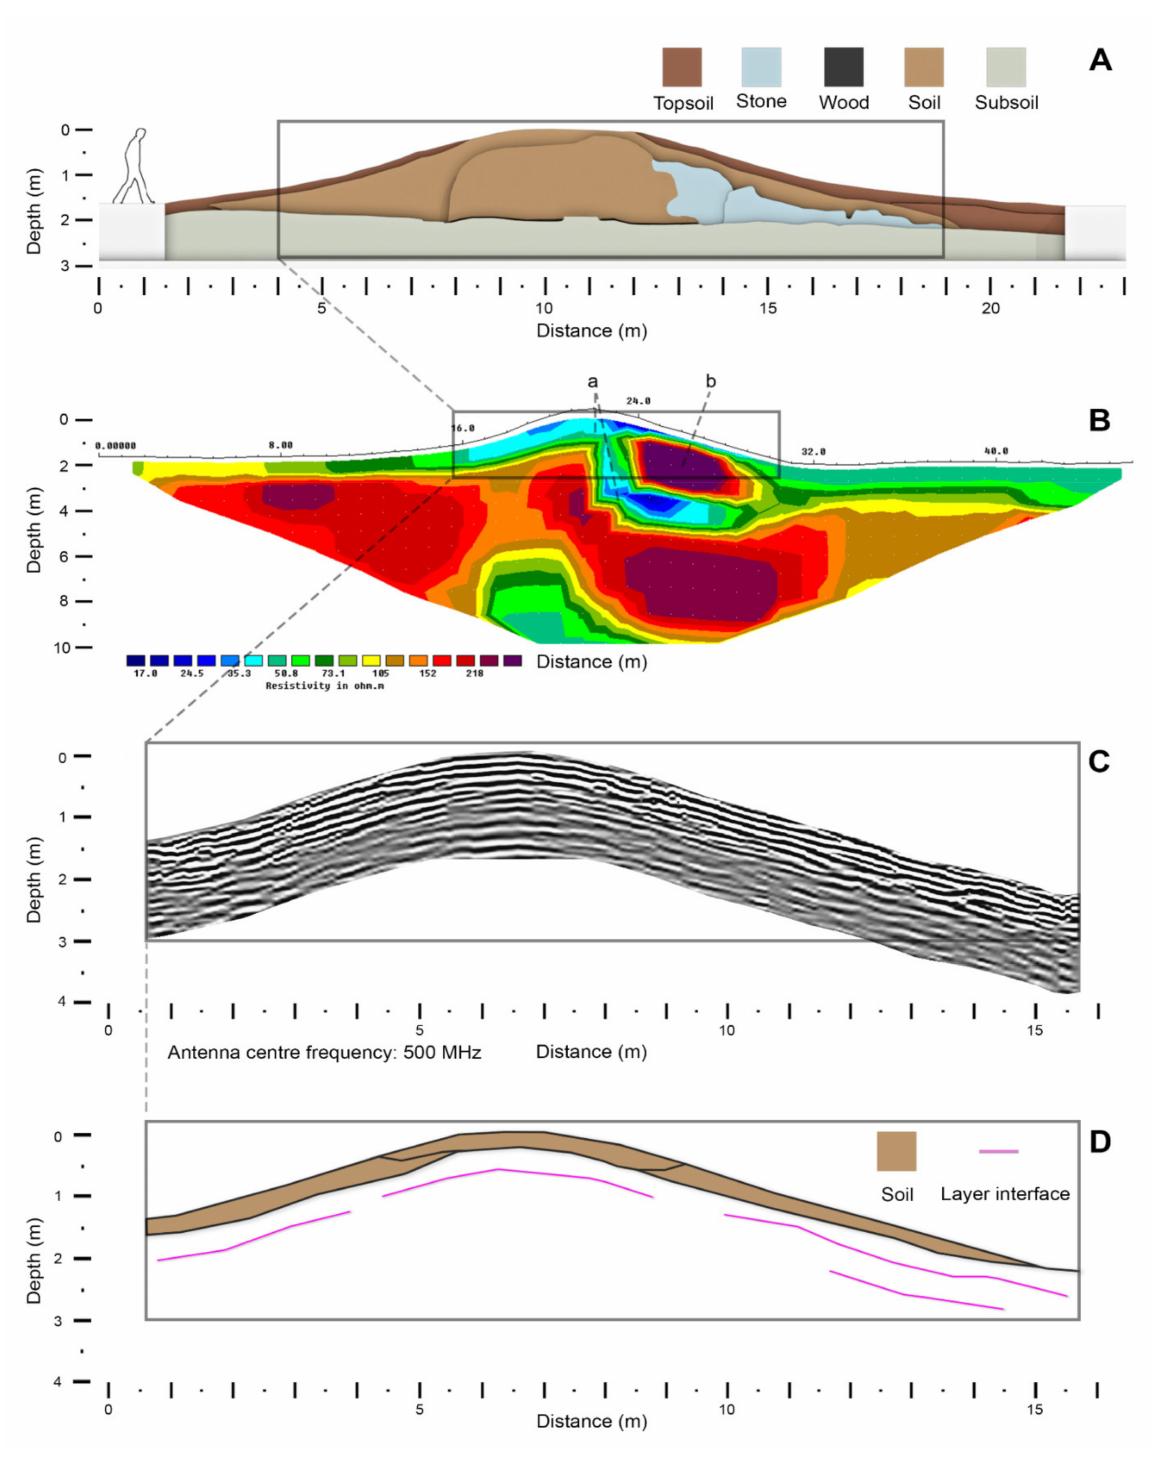
Figure 5. Bˇreclav-Pohansko. ( A ): Profile of the hillfort’s fortification based on the results of archae- ological excavation ([11], Figure 33). ( B ): Electrical resistivity tomography model in Schlumberger configuration. ( C ): GPR vertical time/depth radarogram from an antenna with 500 MHz centre frequency. ( D ): Interpretation of the GPR